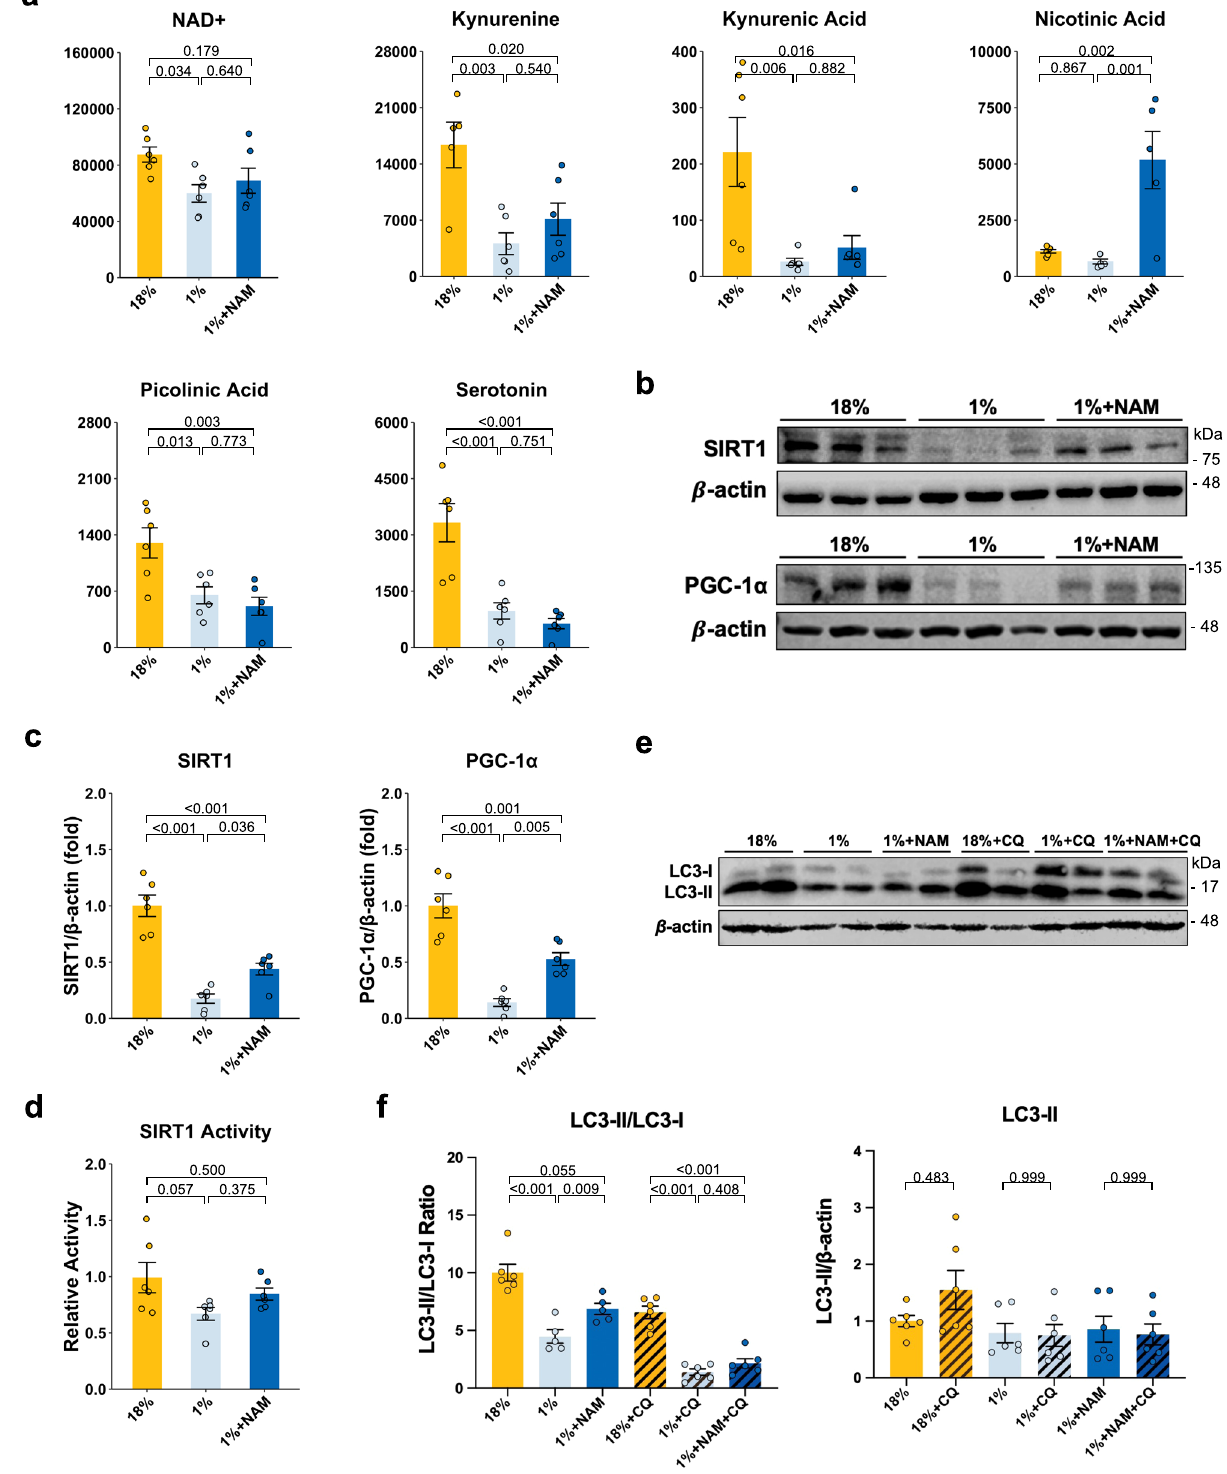
Fig. 5 | The effect of 1% protein feeding with orwithout NAM supplementation on TRP-NAD+pathway metabolites, SIRT1 and downstream targets, and autophagy levels. a Hepatic NAD+levels and TRP-NAD+pathway metabolites ( n =6 per group). b Representative SIRT1 and PGC-1 α western blots. c Quanti fi cation of SIRT1 and PGC-1 α protein levels in western blots ( n =6 per